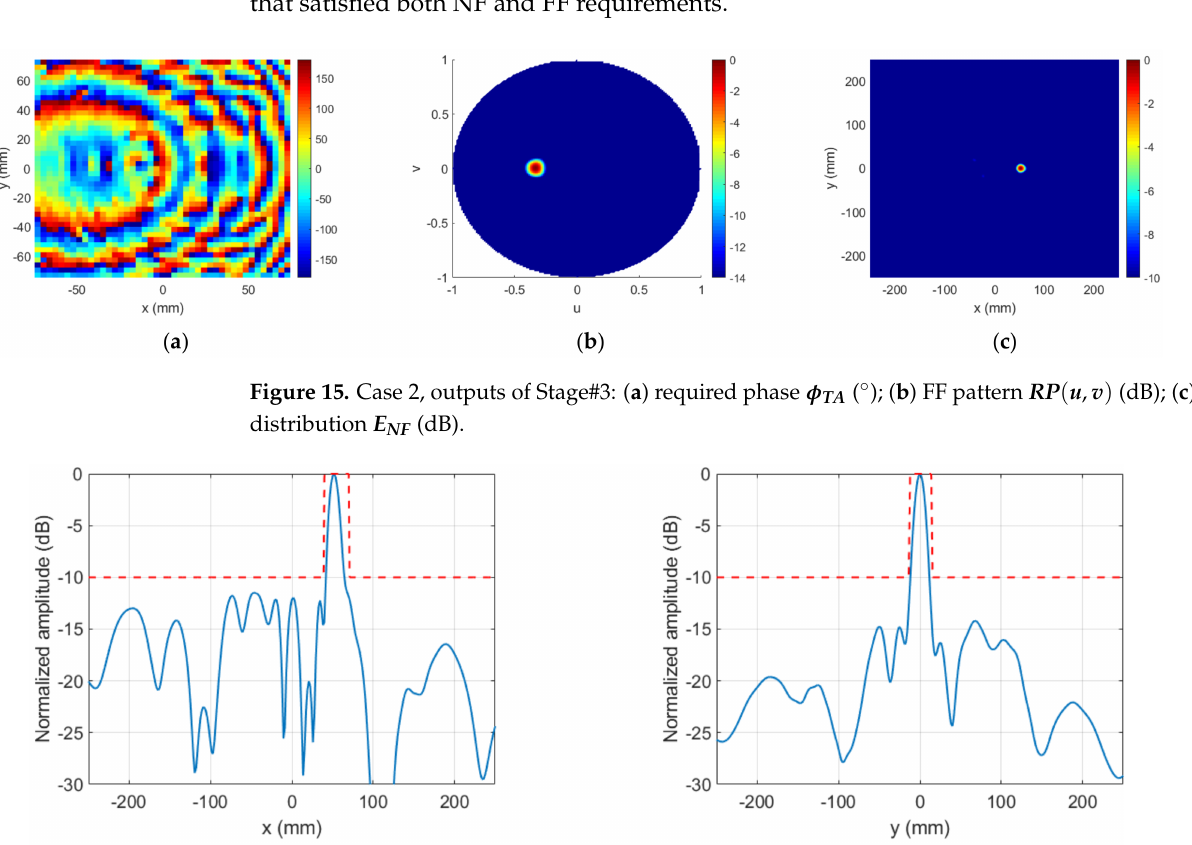
Figure 14. Case 2, outputs of Stage#2: ( a ) required phase φ (cid:48)(cid:48) ( c ) NF distribution E (cid:48)(cid:48) NF (dB) on plane z = 0.6 D .